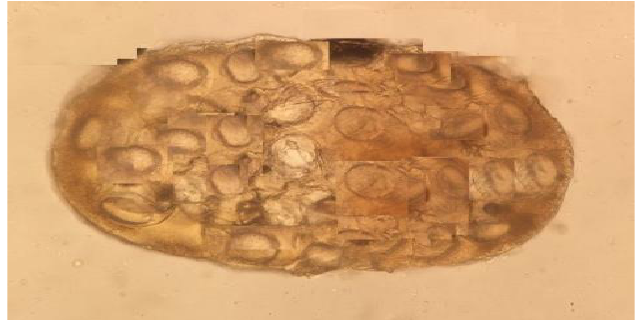
Figure 1. Eggs capsules of Dipylidium caninum under microscopic. 40×